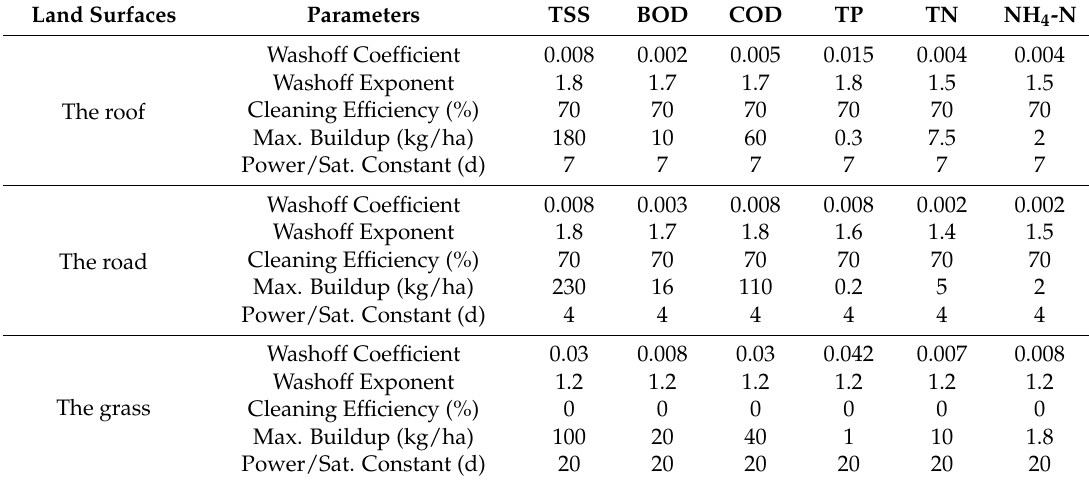
Table 1. The model parameters of pollutant build-up and wash-off